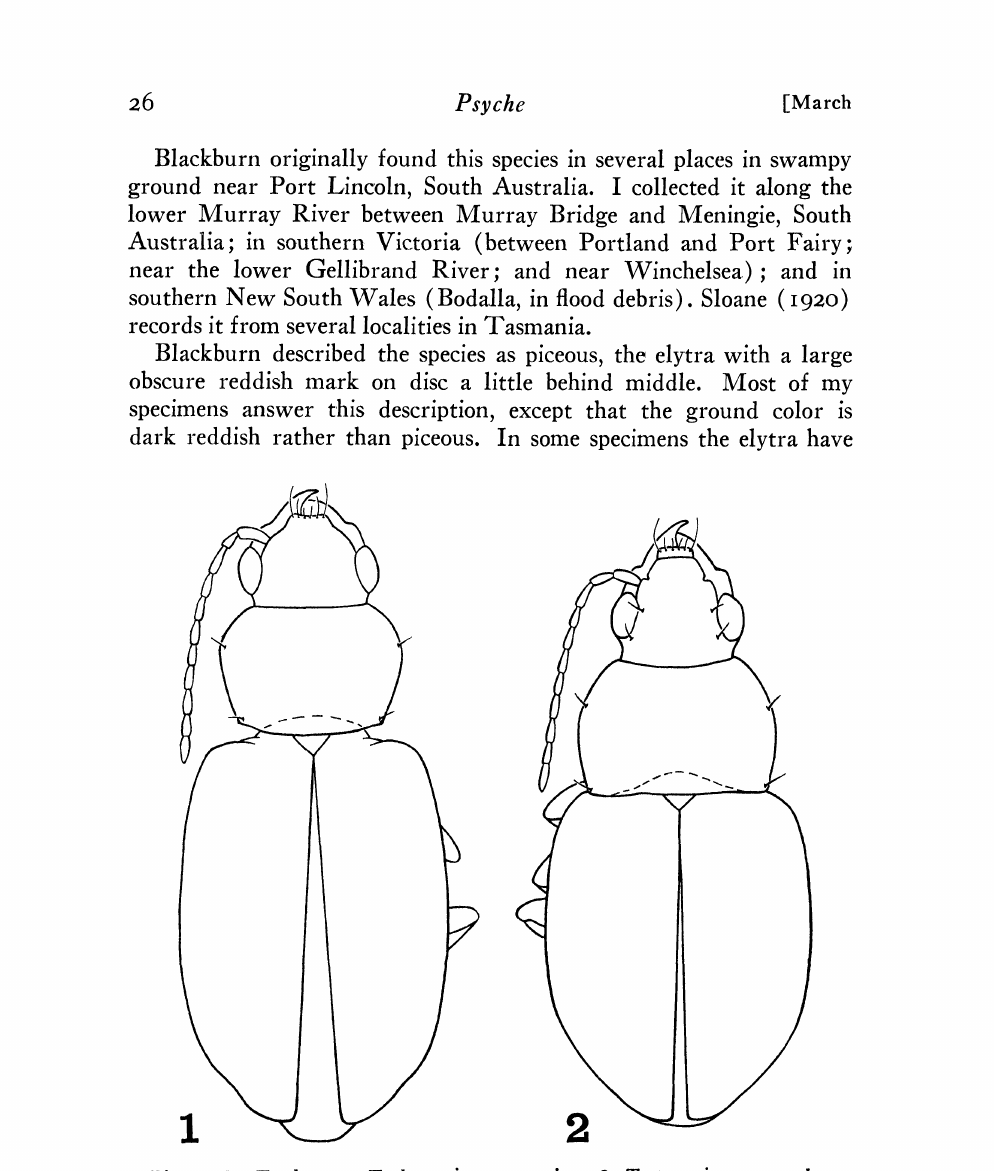
Figs. 1-2. Tachys. 1, T. bogani new species; 2, T. trunci new